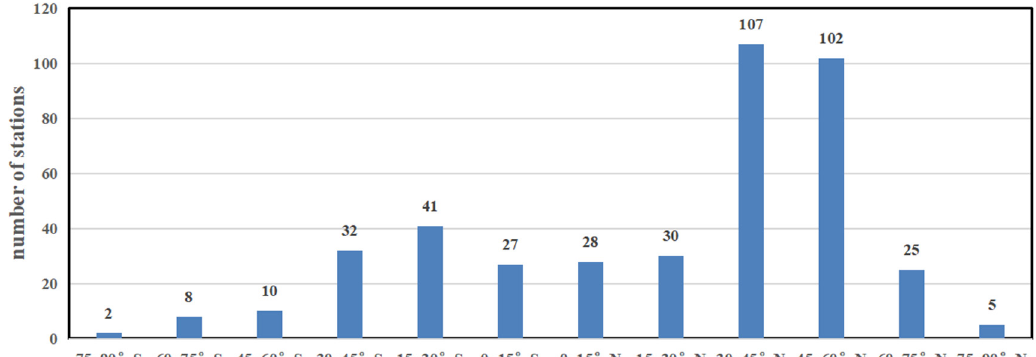
Figure 9. Number of stations at different latitude ranges.